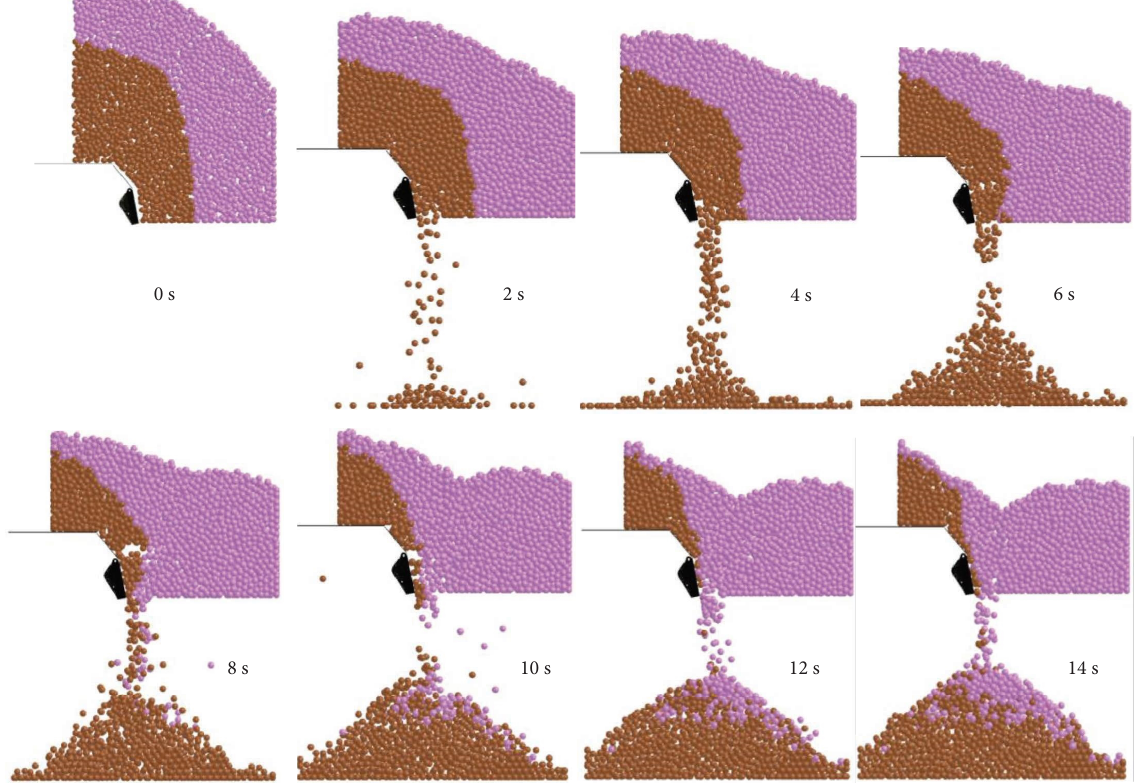
Figure 18: Te evolution of the coal-caving process at 2.8m